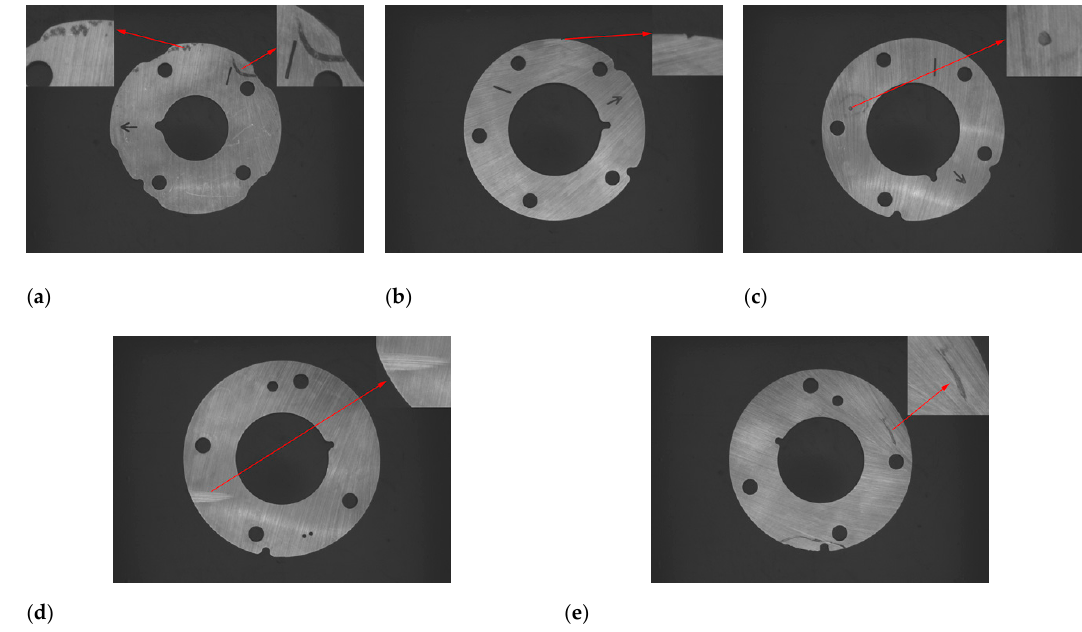
Figure 3. Five kinds of common defects. ( a ) stain; ( b ) misrun; ( c ) indentation; ( d ) edging; ( e )